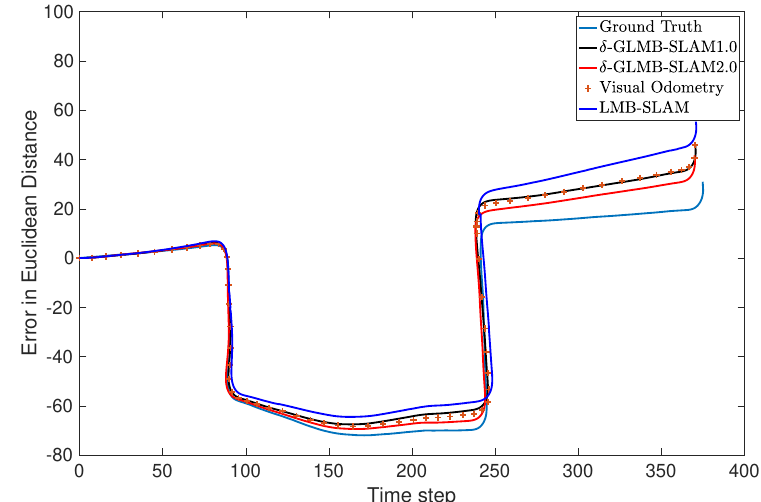
Figure 10. Comparison of the estimated robot trajectories and visual odometry with respect to the ground truth.